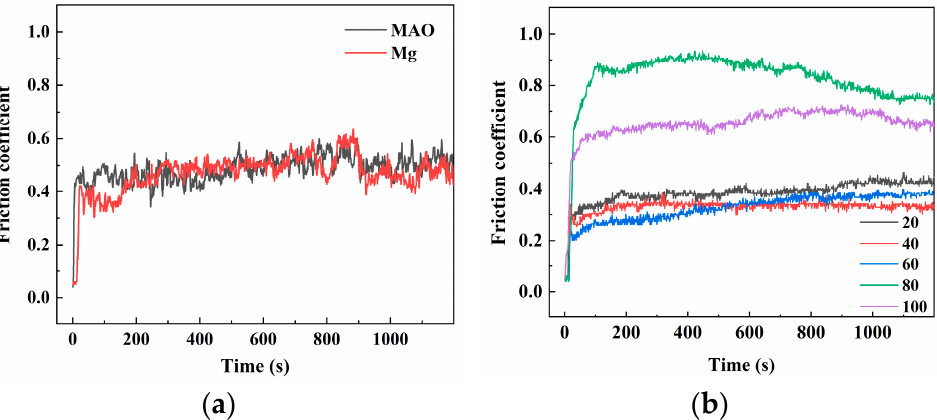
Figure 5. Friction coefficients of the coatings: ( a ) Mg, micro-arc oxidation, and ( b ) graphite/epoxy resin layer.